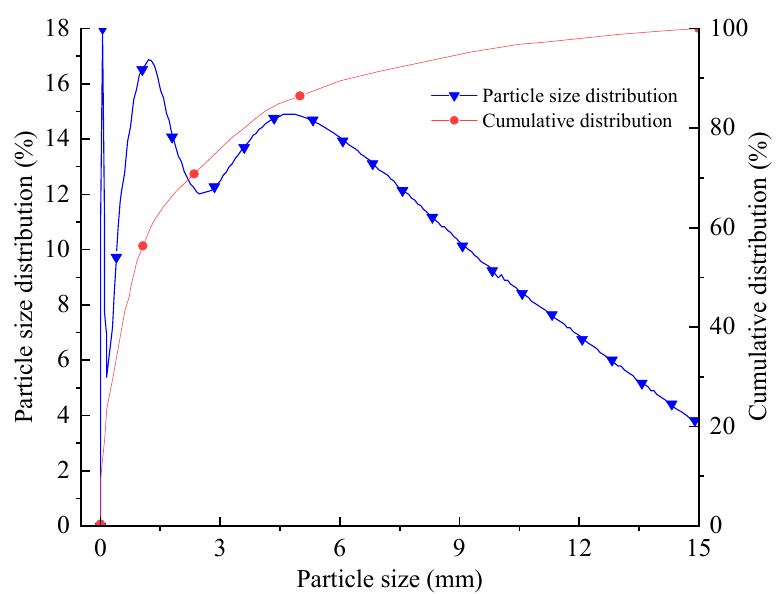
Figure 2. Grain size distribution of gangue in Gaohe coal mine. Table 1. Main components and contents of fly ash.